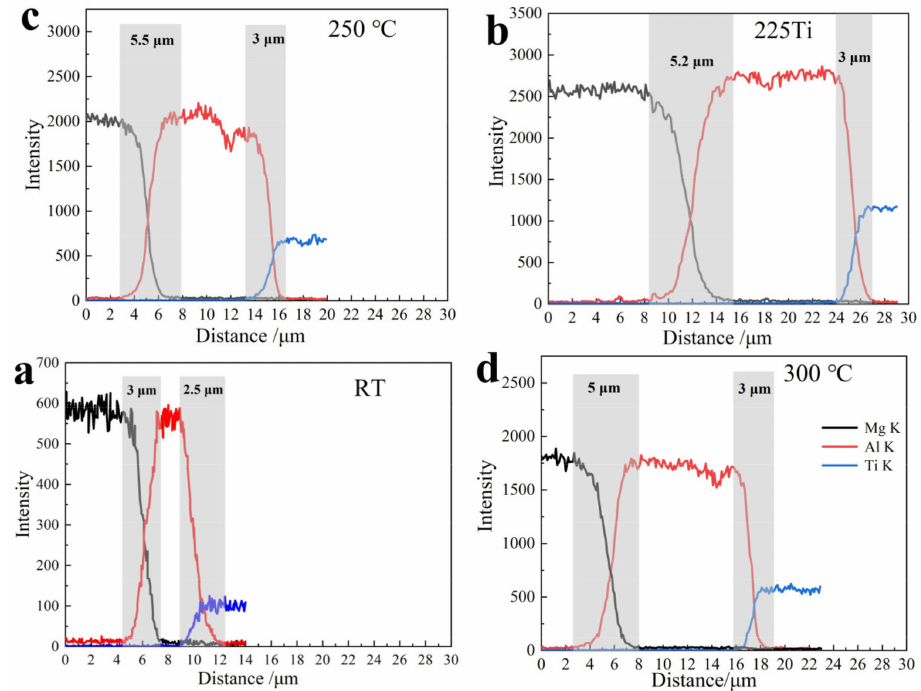
Figure 4. EDS line scanning of Mg-(Al-)Ti sheet rolled with different heat-treated Ti: ( a ) RT; ( b ) 200 ◦ C; ( c ) 225 ◦ C; ( d ) 300 ◦